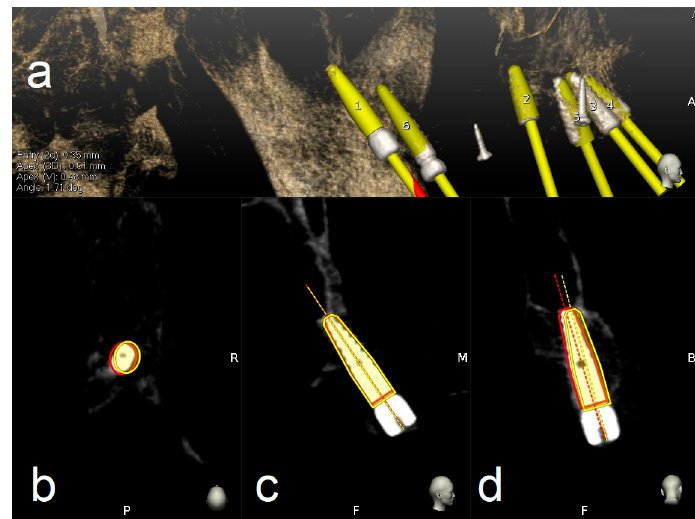
Figure 8. The preoperative surgical plan ( a ) and the postoperative cone beam computerized tomography (CBCT) ( b ) were superimposed using accuracy evaluation software ( c , d ). The registration was performed directly between the two volumetric images.